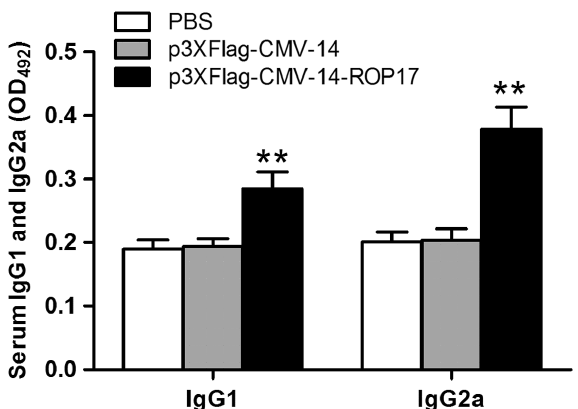
Figure 2. Determination of T. gondii -specific IgG subclass titers in ROP17 DNA-immunized BALB/c mice and controls. The IgG subtypes were determined by ELISA as stated in Figure 1. Results are expressed as means ± SD ( n = 6). * P < 0.05, ** P < 0.01 relative to control groups.